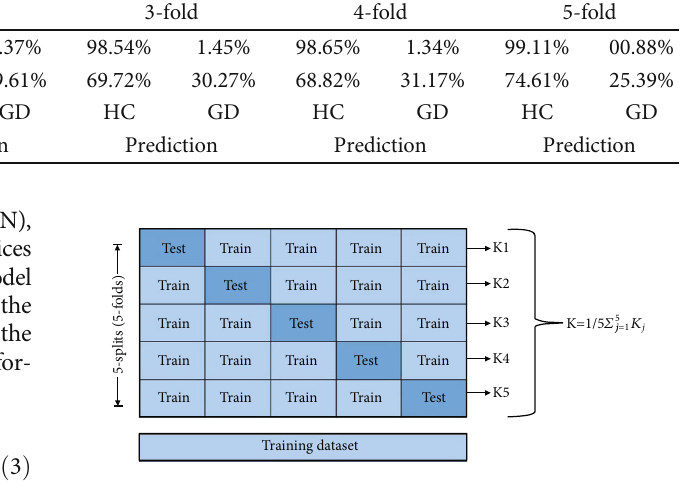
Figure 4: Fivefold cross-validation